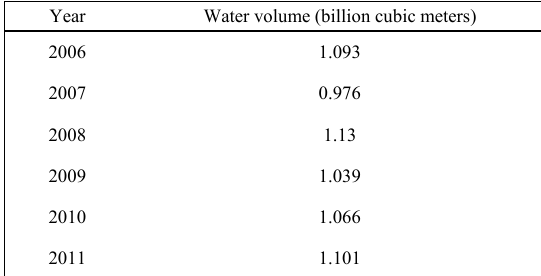
Figure 7. (a)Spatial distribution of the discontinuous pattern “442444”(in red), (b) Partial enlarged image detail of (a) In Figure 7, the pixels within the red area represent the pattern “442444” and they are mainly located on the waterside of Miyun Reservoir. The “442444” pattern means that since 2006, except for 2008, the area represented by this pattern belonged to cluster 4 (water bodies). However, in 2008, this area belonged to cluster 2 (bare land). In other words, these areas were not covered by water at the end of May 2008 (the acquisition time of the image was May 30, 2008). Table 7 shows the end-of-year water storage of the Miyun Reservoir from 2006 to 2011, according to the “Beijing Water Resource